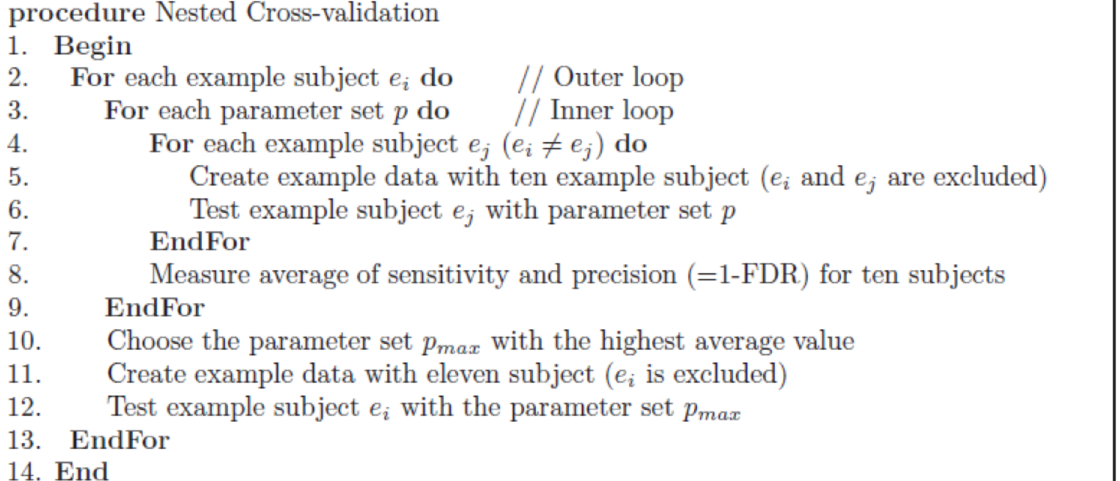
Fig 5. Skeleton of nested cross-validation. The skeleton of the nested cross-validation for measuring the performance of the proposed